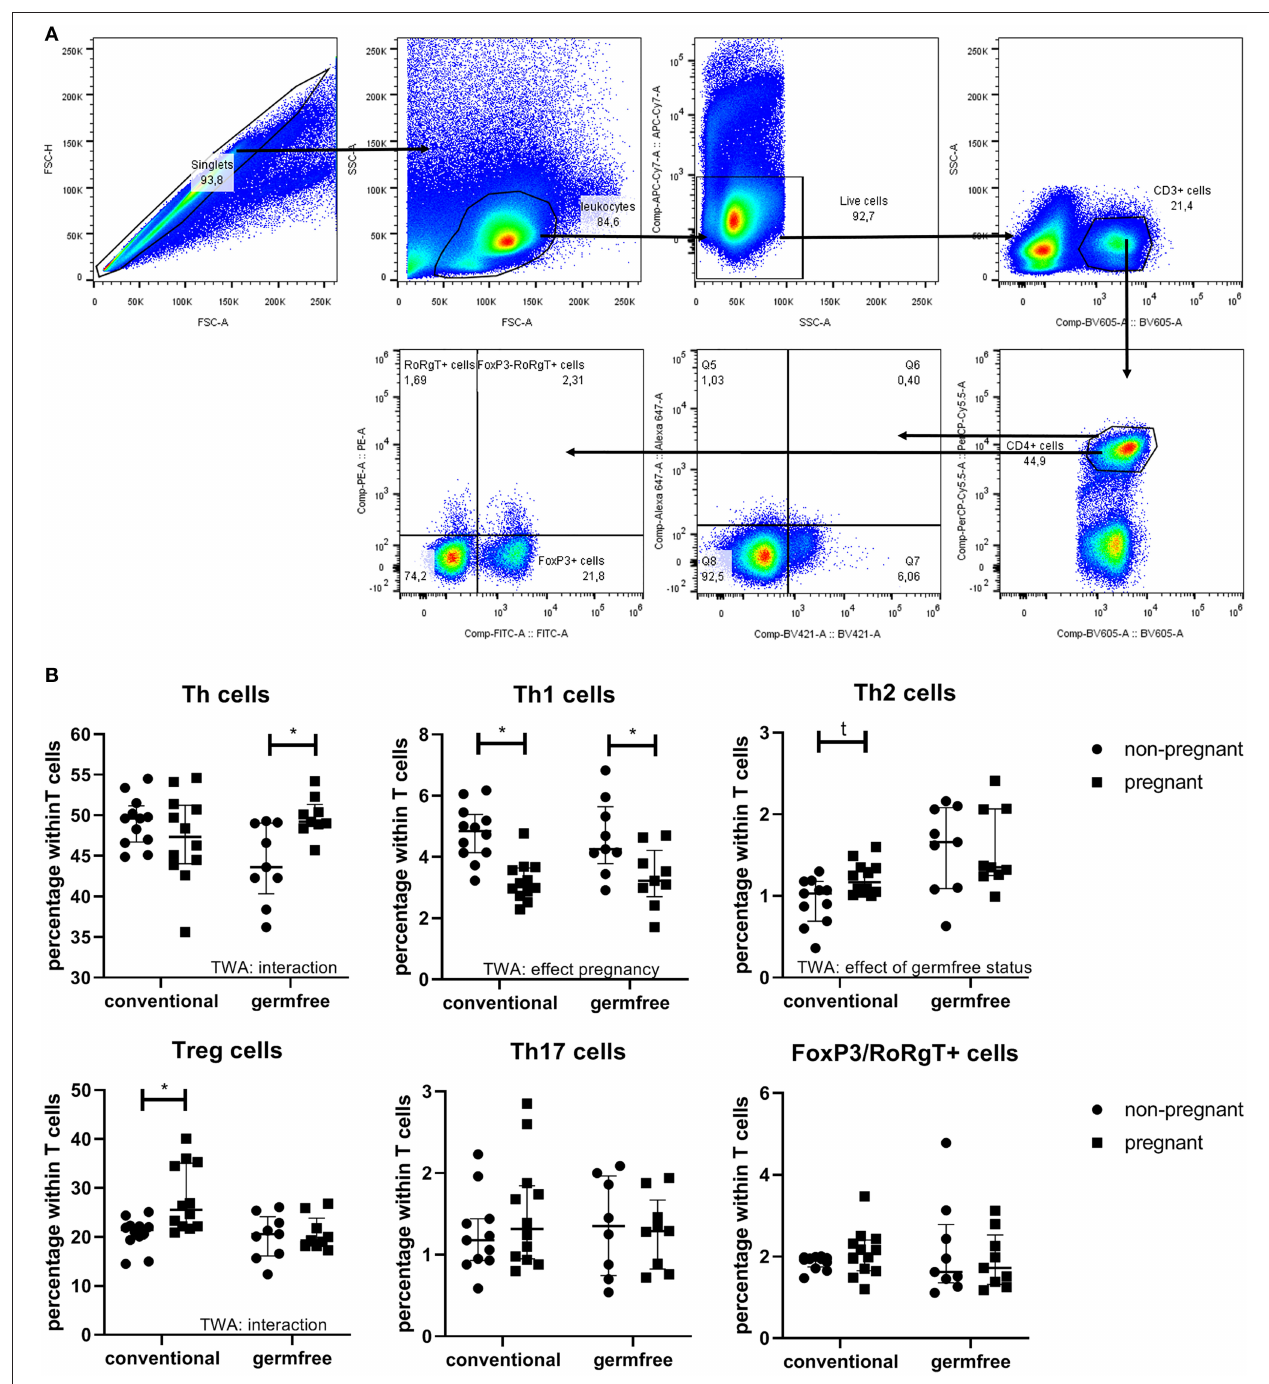
FIGURE 6 | (A) Gating strategy for lymphocyte subsets. First singlets and live cells were selected and copied to the FSC-SSC plot. In this plot, leukocytes were selected and copied to an SSC-BV605 plot, in which the CD3 + cells were selected. The CD3 + cells were copied to a BV605-PerCP-Cy5.5 plot to selected the CD4 + cells. CD4 positive cells were copied to a BV421-Alexa647 plot (to select Tbet + cells and Gata3 + cells) and to a FITC-PE plot (to select FoxP3 + cells and RoRgT + cells). For gate setting of the latter two plots we used FMOs. (B) Percentage of splenic Th cells, Th1 cells, Th2 cells, Treg cells, Th17 cells, and FOXP3/RORgT double positive cells (within the T cell population) of pregnant and non-pregnant conventional and germfree mice. TWA, Two-way ANOVA. *Significantly different from non-pregnant mice (TWA followed by Fisher’s LSD post-test, p < 0.05). t: significant trend from non-pregnant mice (TWA followed by Fisher’s LSD post-test, p < 0.1).